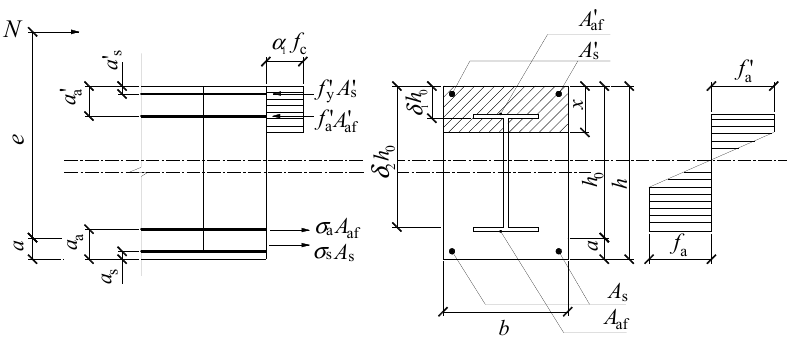
Figure 16. The stress distribution based on code JGJ138-2016.